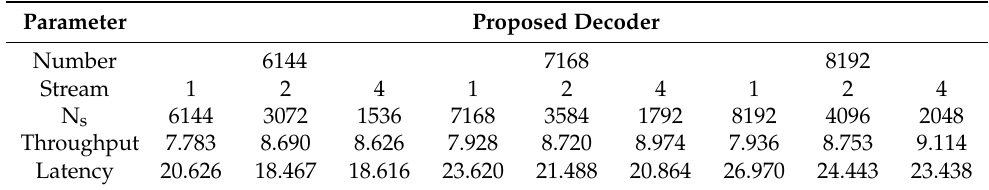
Table 3. Throughput and latency performance with different combinations of Stream and N s for the proposed